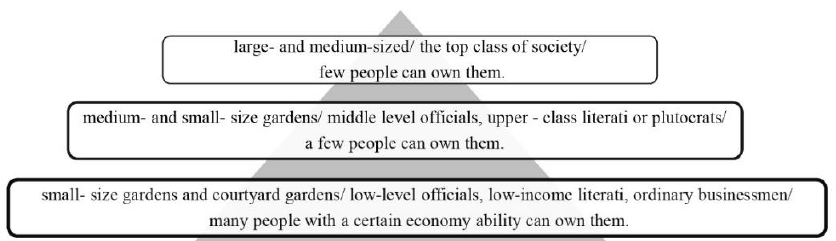
Figure 11. The pyramidal relationship between the scale, owner status, and the number of Suzhou gardens in the Qing Dynasty.